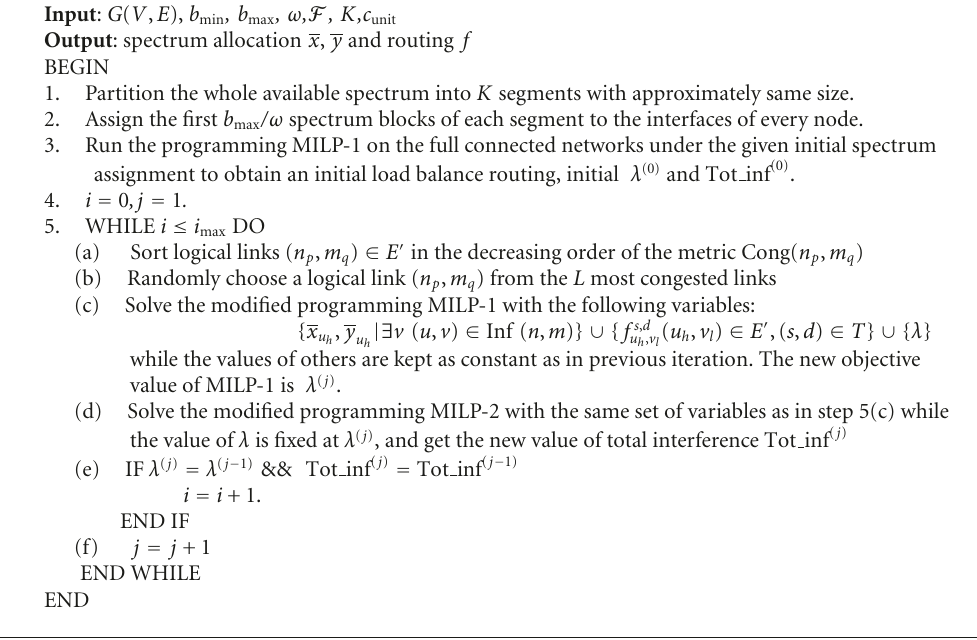
Algorithm 1: MILP-based Heuristic Iterative Local Search